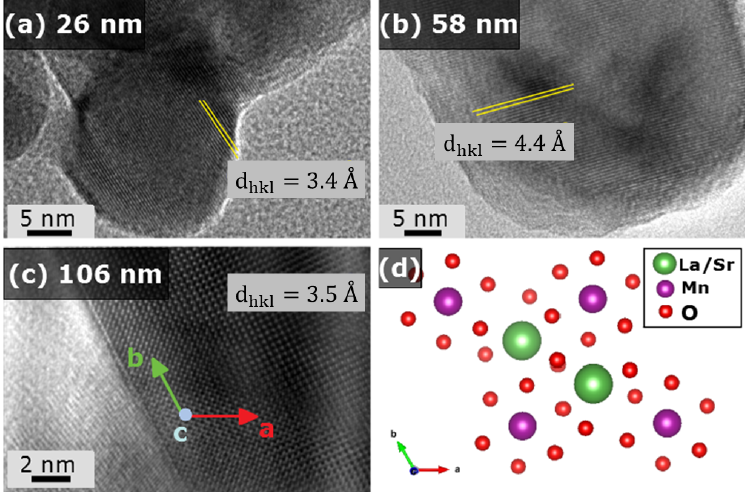
Figure 3. High-resolution images for the nanoparticles with ( a ) 26 nm, ( b ) 56 nm and ( c ) 106 nm with the respective d-spacing. The super-lattice given on ( d ) is clearly observed for the bigger nanoparticle, indicating a close behavior to their bulk counterpart. Vesta software was used to acquire the structural image